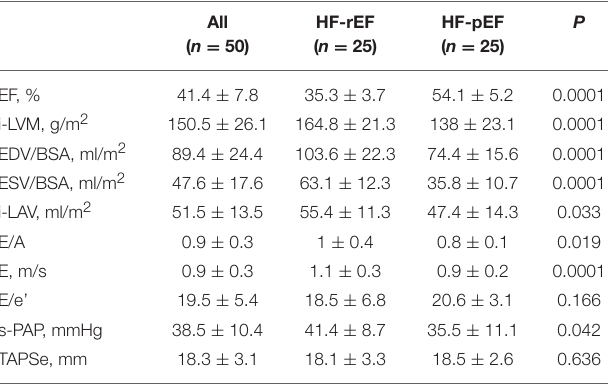
TABLE 3 | Echocardiographic parameters of the whole study population and of the two groups separately.